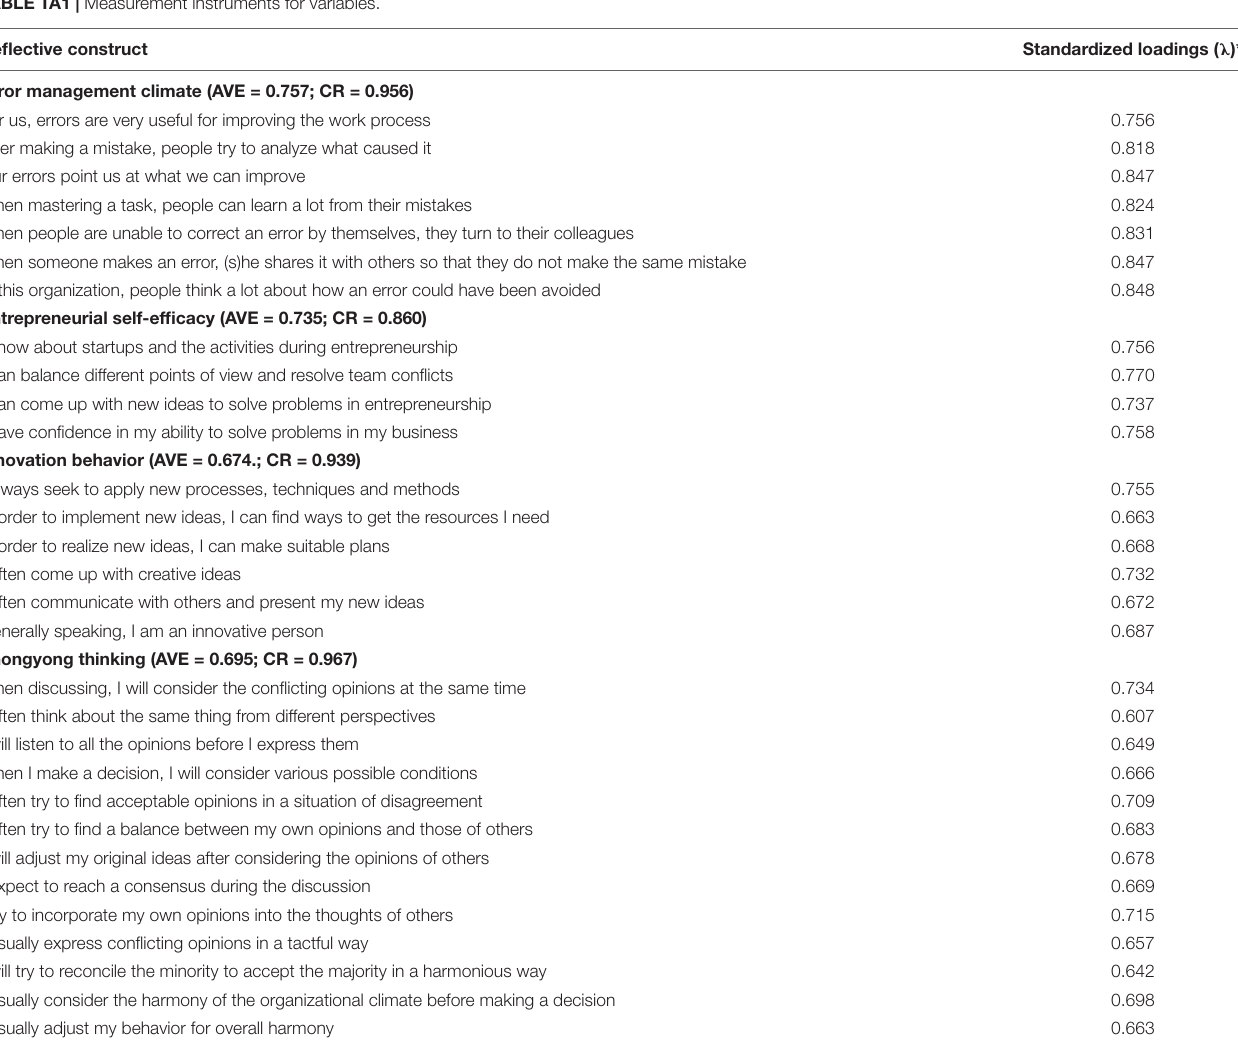
TABLE TA1 | Measurement instruments for